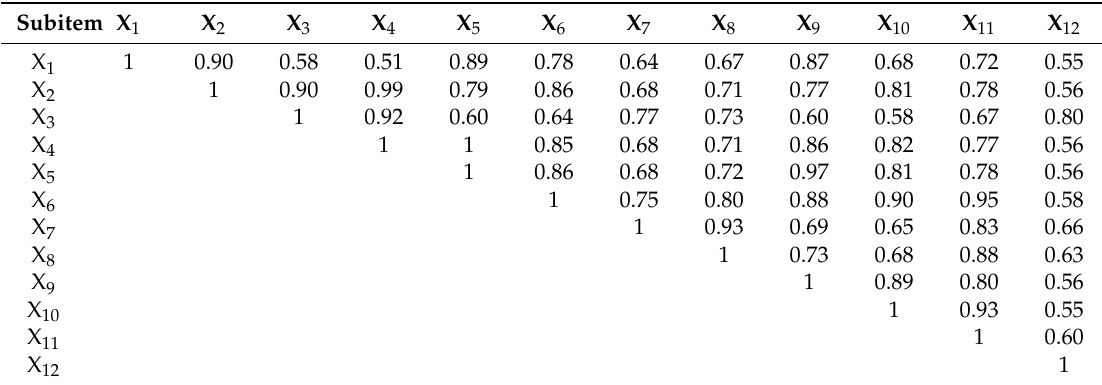
Table 5. The upper triangular matrix for the Level 3 evaluation